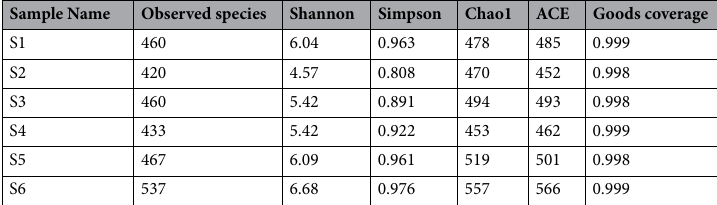
Table 4. Sludge sample sequencing information and microbial diversity index.